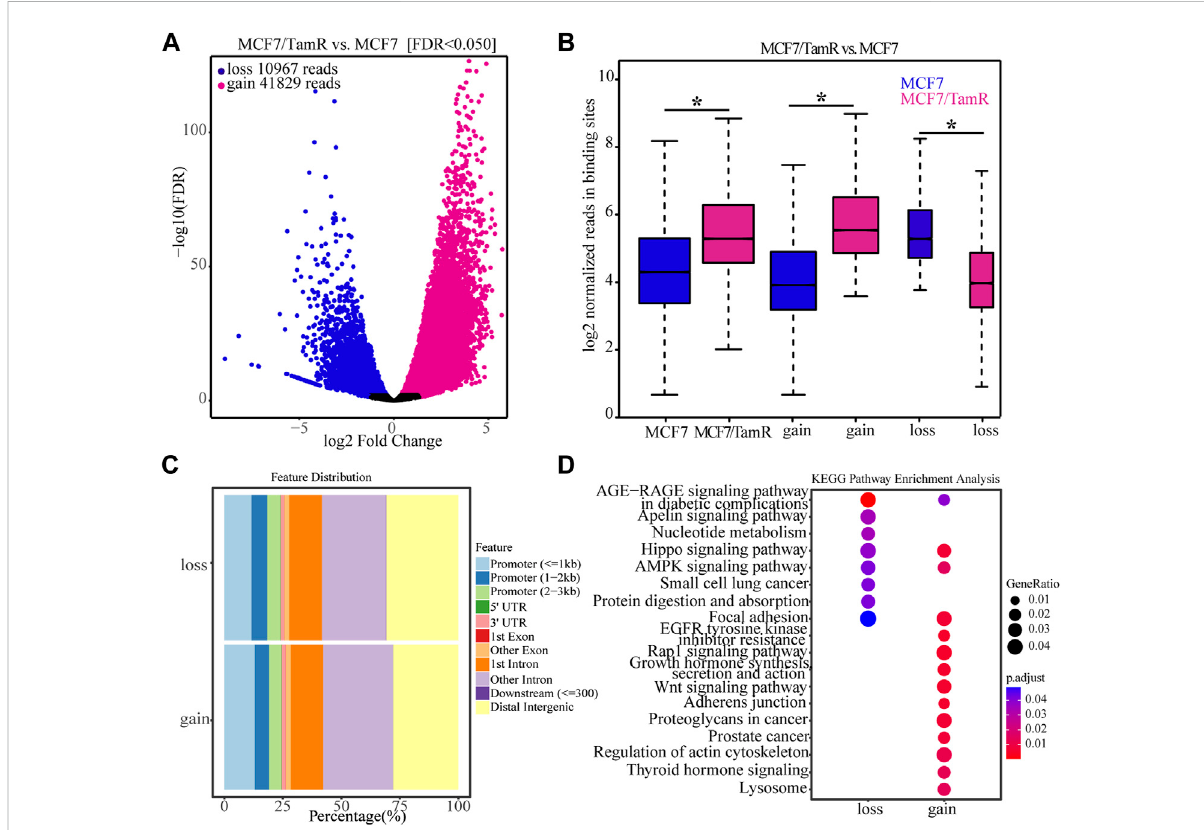
FIGURE 2 TheFOXA1gainedandlostchromatinbindingreadsinMCF7/TamRcells. (A) VolcanoplotoftheFOXA1gainedandlostchromatinbindingreads in MCF7/TamR cells, red dot represents gain and blue dot represents loss. (B) Box plot of the FOXA1 gained and lost chromatin binding reads in respectivelyMCF7andMCF7/TamRcells,redboxrepresentsMCF7/TamRcellsandblueboxrepresentsMCF7cells. (C) Thefeaturedistributionofthe FOXA1 gained and lost chromatin binding reads in MCF7/TamR cells. (D) Dot plot of the function enrichment analysis of the FOXA1 gained